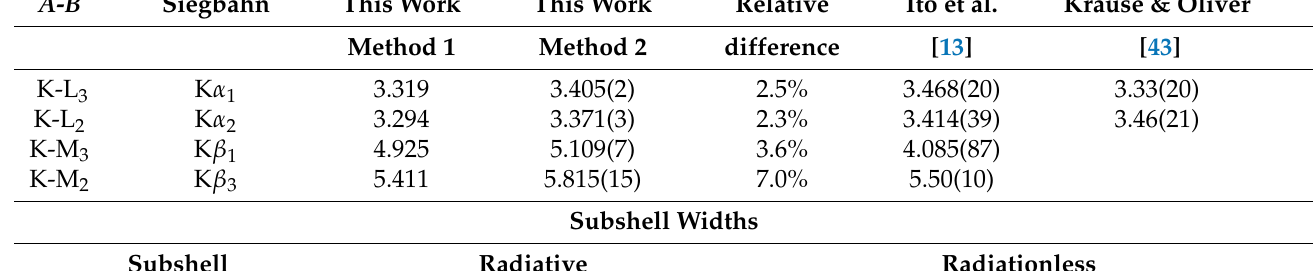
Table 2. Subshell linewidths, Γ A − B , and partial subshell widths divided into their radiative and radiationless parts, in eV. A -